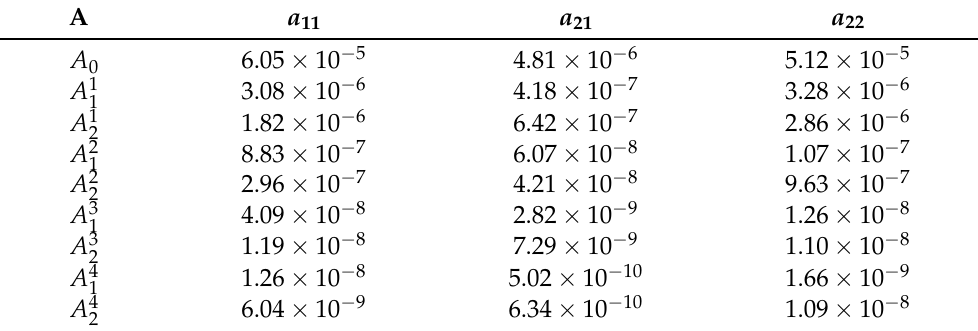
Table A1. The polynomial coefficients in the random ternary interdiffusion system, where a ij represents the entries in the coefficient matrix on position { i , j } , i = 1, 2, j = 1, 2.